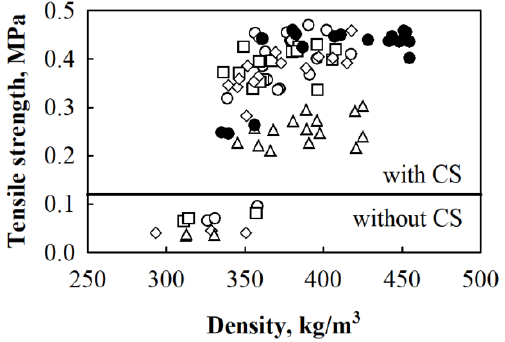
Figure 10. Relationship between tensile strength and density where designated dots present experimental data for BcB from HS fraction, mm: ○ — 5/10; □— 10/20; ◊—2.5/20; Δ—2.5/5; ●— shredded HS; ( ─── ) — separation line for results obtained from specimens with and without CS binder.